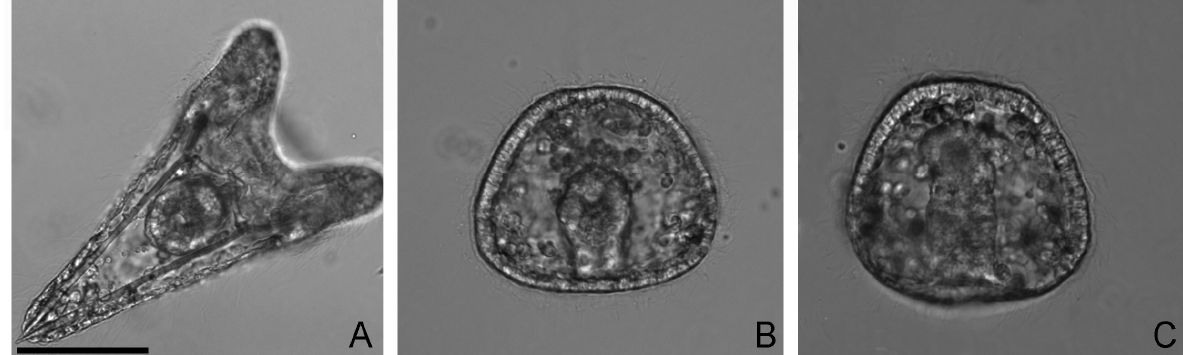
Figure 1. Pictures of representative embryos at 36 h of development/treatment. Control embryo ( A ), 1 mM V-treated embryo ( B ), 500 µ M V-treated embryo ( C ). Bar: 100 μ m.